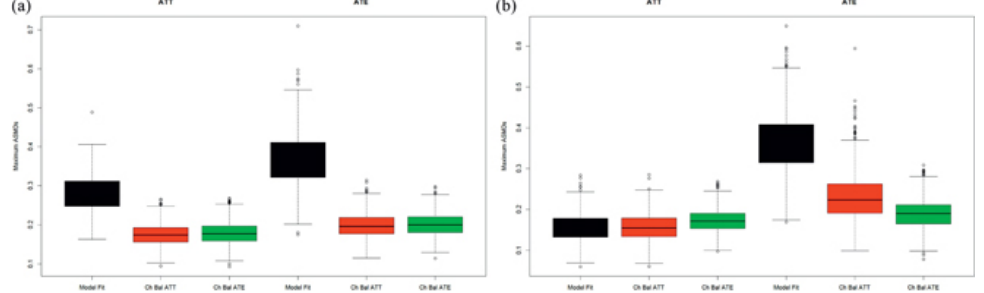
Figure 2: Maximum mean ASMD for Model A data generation and four covariates used in propensity score estimation (no distractors case) for (a) the PA and (b) the abstainers data generation case studies.